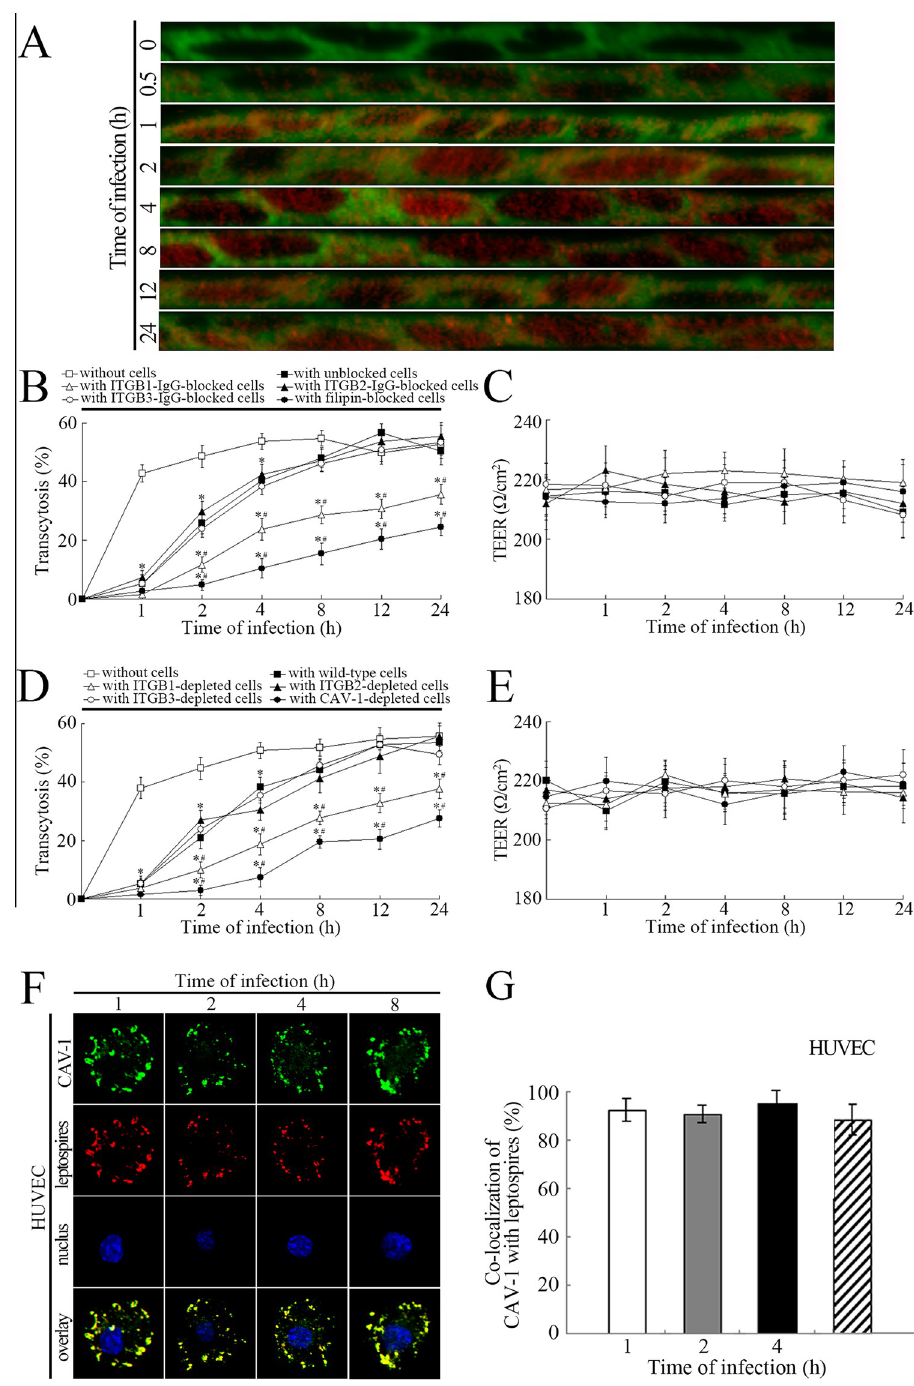
Fig 6. Powerful transcytosis ability of Leptospira through HUVEC monolayer. A: Laser confocal microscopic 3D- image reflecting L . interrogans strain Lai transmigrating HUVEC monolayer for the indicated times. The green plaques indicate the cell monolayers. The black plaques indicate the nuclus. The red spots indicate the intracellular leptospires; B: Transcytosis of L . interrogans strain Lai through HUVEC monolayer for the indicated times and transcytosis inhibition effects of ITGB1-IgG and filipin. � : p < 0.05 vs the transcytosis percentages of the spirochete transmigrating wells without cells. # : p < 0.05 vs the transcytosis percentages of the spirochete transmigrating wild-type HUVEC monolayers; C: The TEER of HUVEC monolayer during transcytosis of L . interrogans strain Lai that shown in Fig 4B; D: Transcytosis of L . interrogans strain Lai through the intergrin β subunit or CAV-1 encoding gene depleted